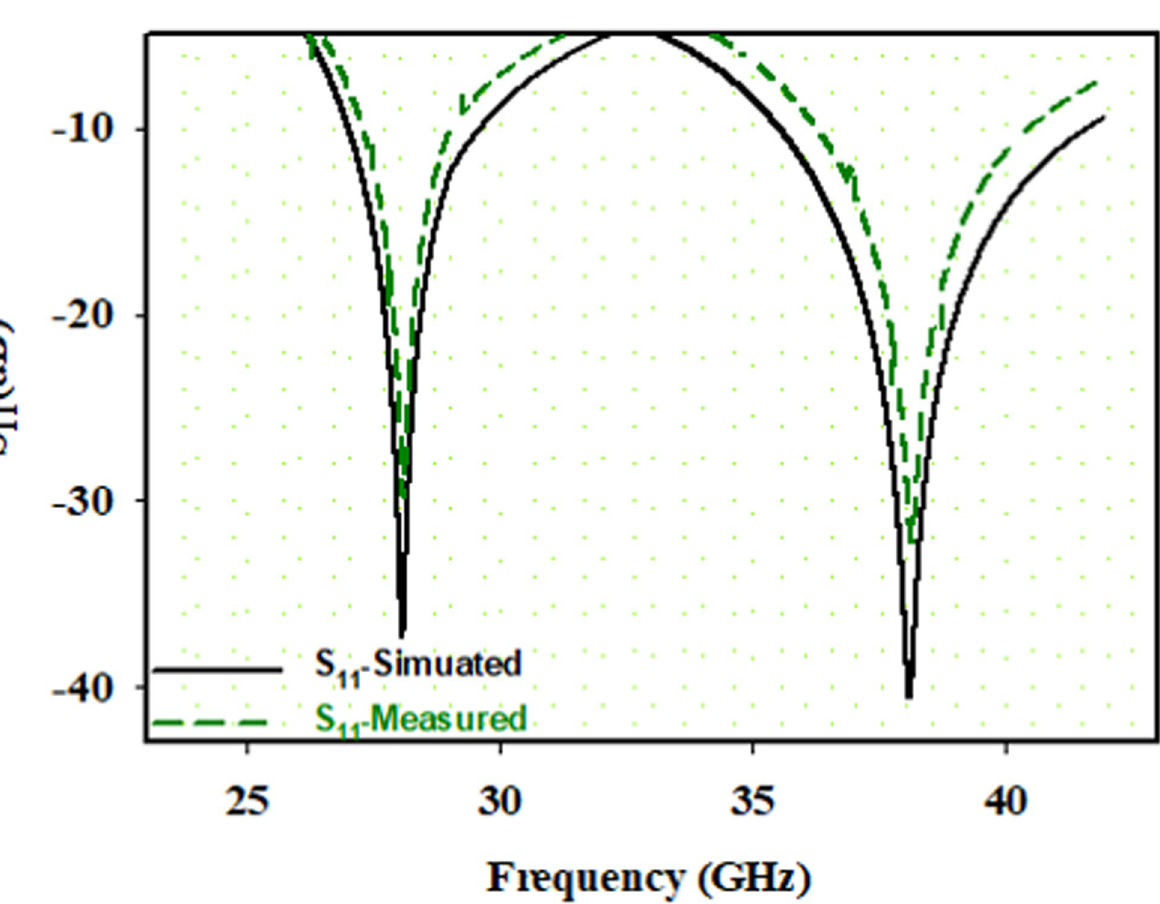
Where Δ S is the total area of square patches (P1_28 & P2_38) and S is area of square patch i.e. S = (psl) 2 .